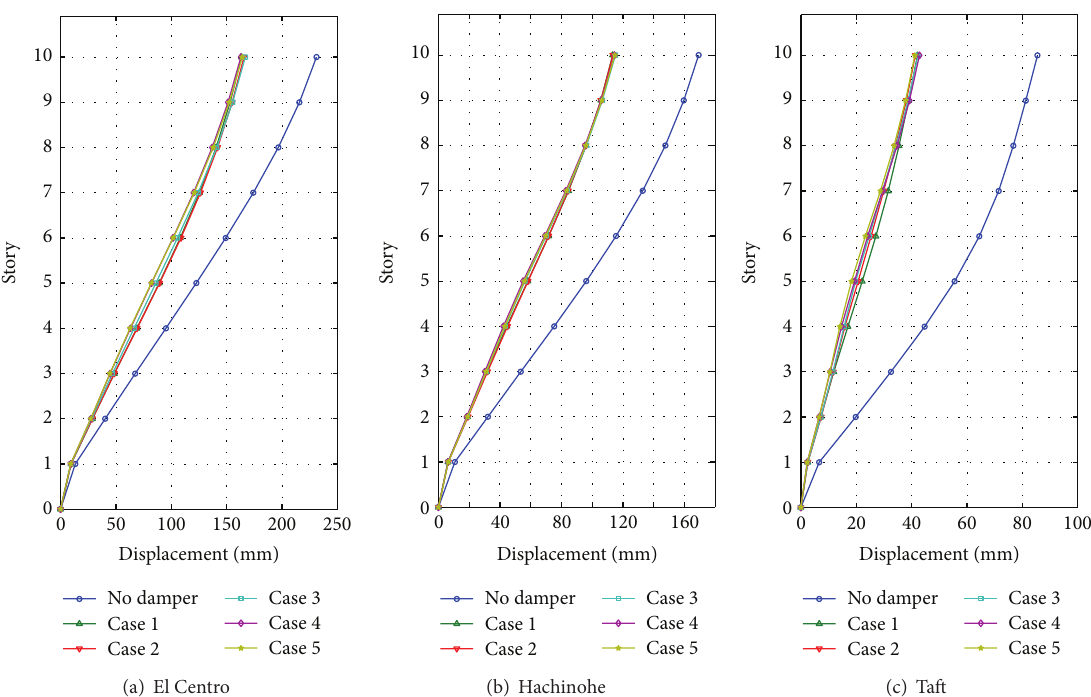
Figure 8: Comparative maximum story displacements subject to input earthquakes.